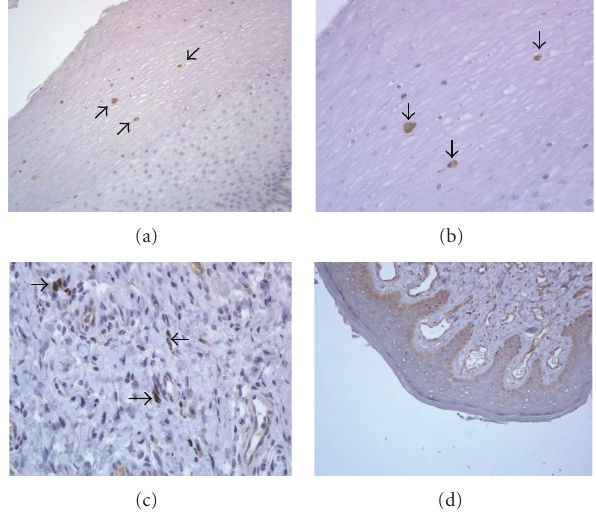
Figure 3: Detection of XMRV gag in the cervix (a, b) and vagina (c) of the female rhesus macaque (RYh-10, day 291/133 pi), and in the vagina of a control female rhesus macaque RFm-2 (d). Magnification, × 200 (a, d), × 400 (b,